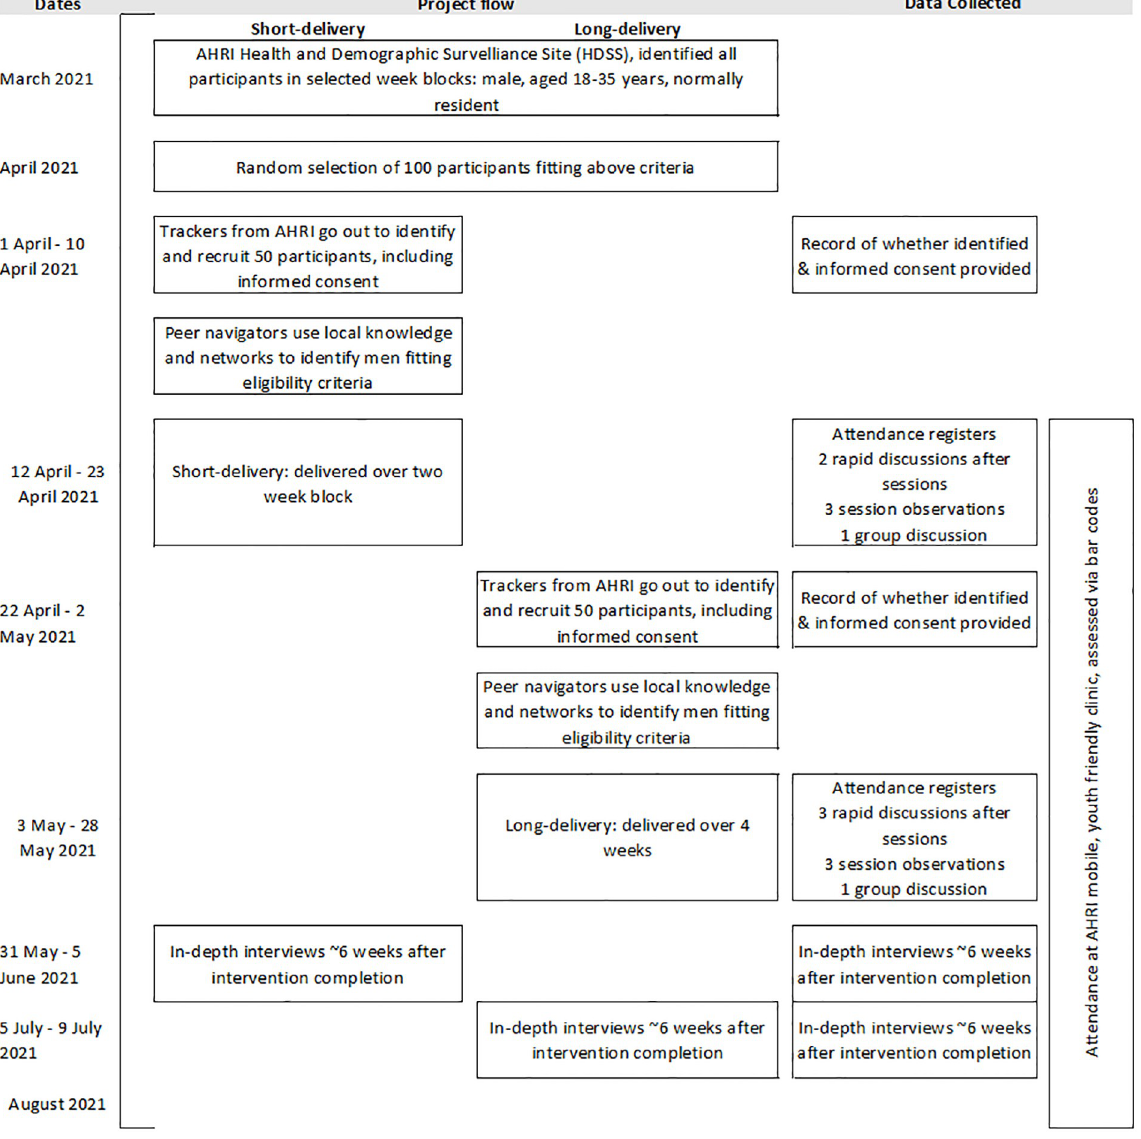
Fig 1. Timeline of the ‘pre-test’ of short- and long-delivery format Stepping Stones and Creating Futures intervention, with participant data collected.